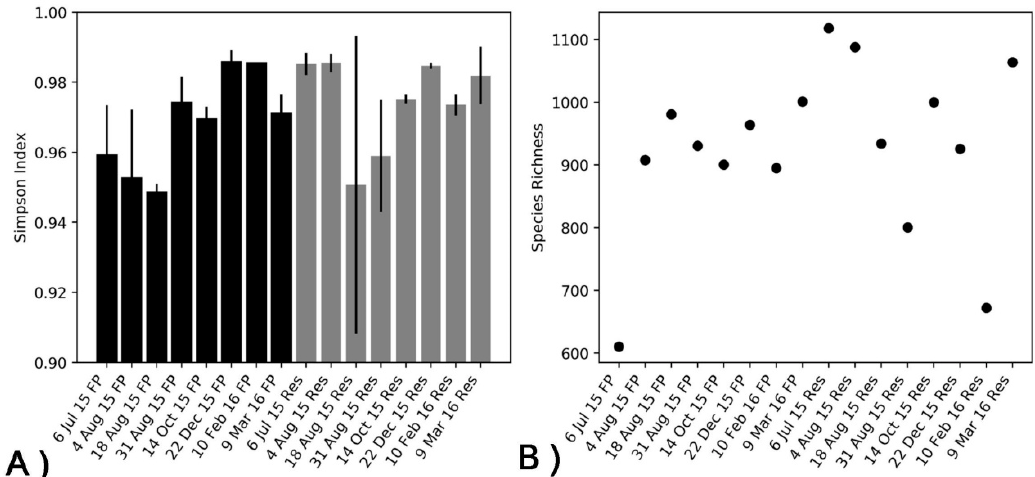
Figure 1. Temporal (alpha) diversity in the FP-03 (FP) and Res (Res) water columns at the Dor aquaculture research station based on analyses of 16S rRNA gene amplicon sequencing reads. ( A ) Simpson index and ( B ) Species Richness. Microorganisms 2020 , 8 , 1984